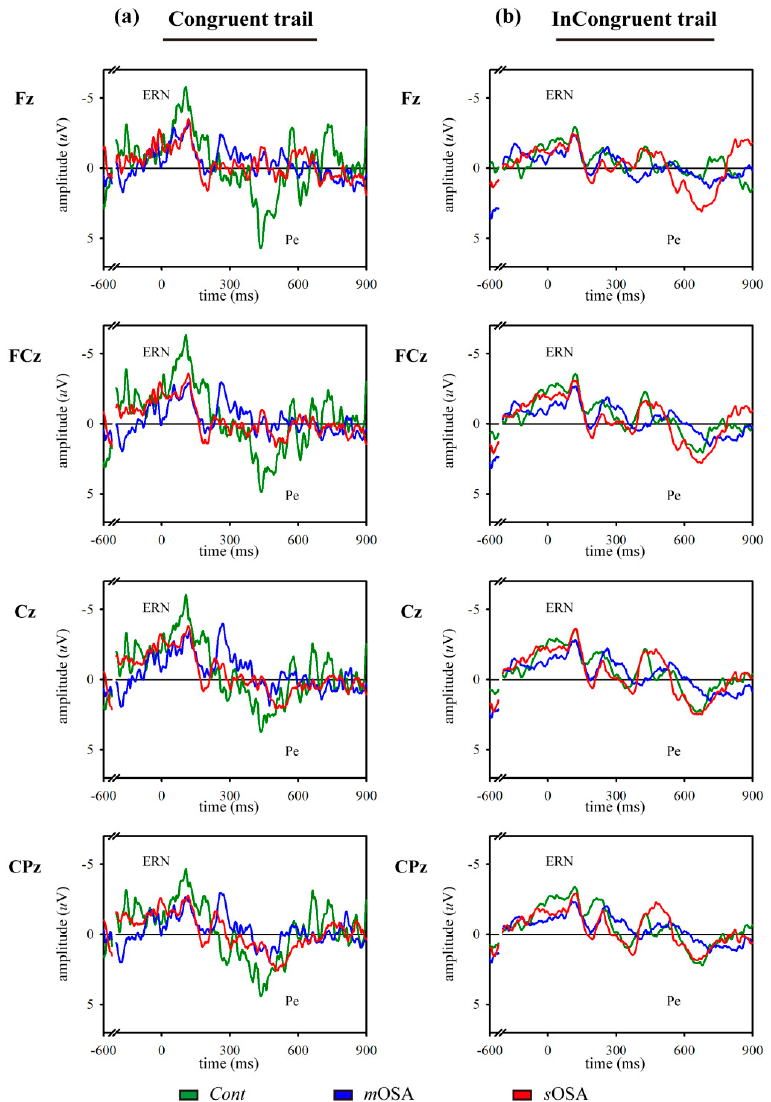
Figure 1. Signals of event-related potentials to error response in congruent ( a ) and incongruent ( b ) trials. Two tasking trials and four channels are demonstrated in the three groups. Results of the Cont , m OSA, and s OSA groups are presented in green, blue, and red, respectively. The amplitudes of ERN and Pe decreased in m OSA compared with Cont . In s OSA, the amplitudes of ERN and Pe increased compared with m OSA. A compensatory neural recruitment for action-monitoring dysfunction during the transition from m OSA to s OSA is observed. Abbreviations: Cont , Control group; m OSA, moderate OSA group; s OSA, severe OSA group; OSA, obstructive sleep apnea; ERN, error-related negativity; PE, error positivity.